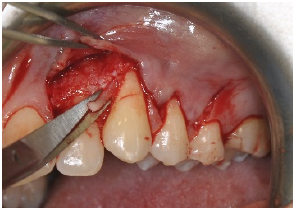
Figure 5. De-epithelization of anatomical papillae.